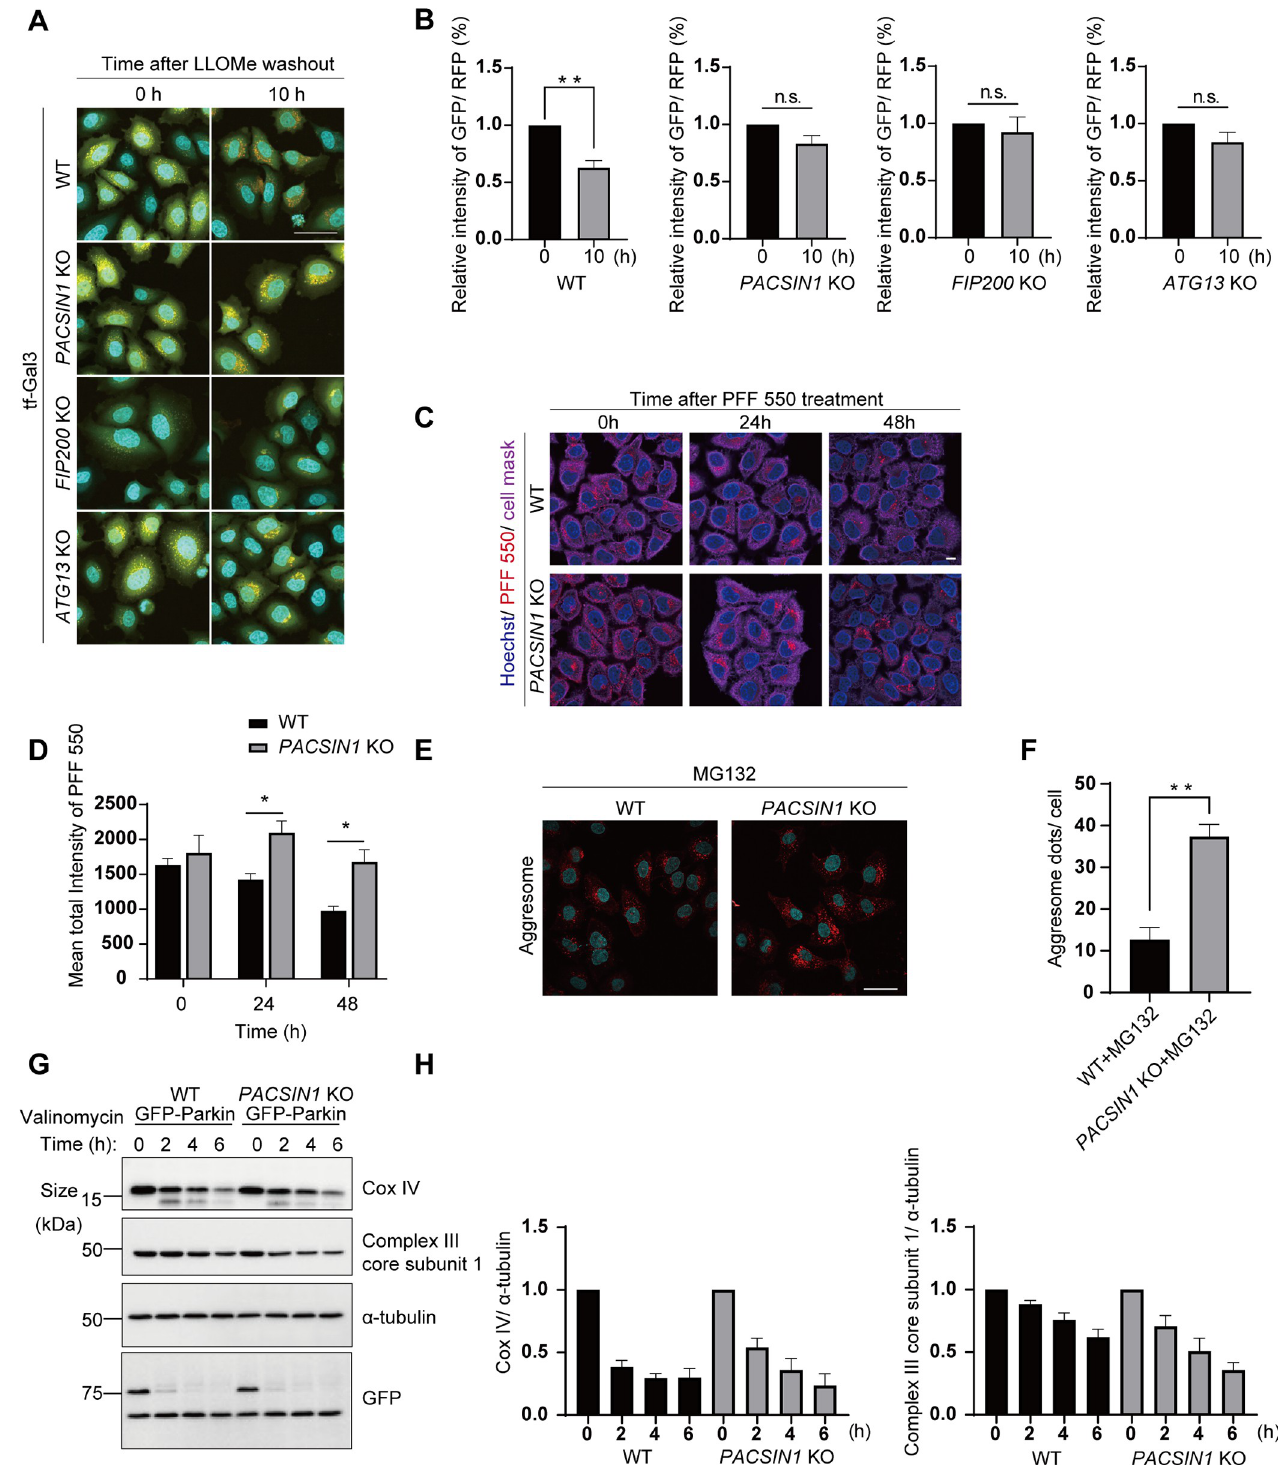
Fig 6. PACSIN1 is indispensable for lysophagy, aggrepahgy but not mitophagy. (A) WT, PACSIN1 KO, FIP200 KO, and ATG13 KO HeLa cells stably expressing tf-Gal3 were cultured for 0 h or 10 h in growth medium after 1 mM LLOMe treatment for 1 h. Scale bars, 50 μ m. (B) After fixation, cells were analyzed and the relative mean intensity of GFP/RFP was measured using CQ1 software. More than 100 cells were analyzed per condition in each experiment (n = 3), mean ± s.e.m. n.s.; not significant. P value ( �� p < 0.01) was determined by the two-tailed, unpaired t-test. (C) WT or PACSIN1 KO HeLa cells were